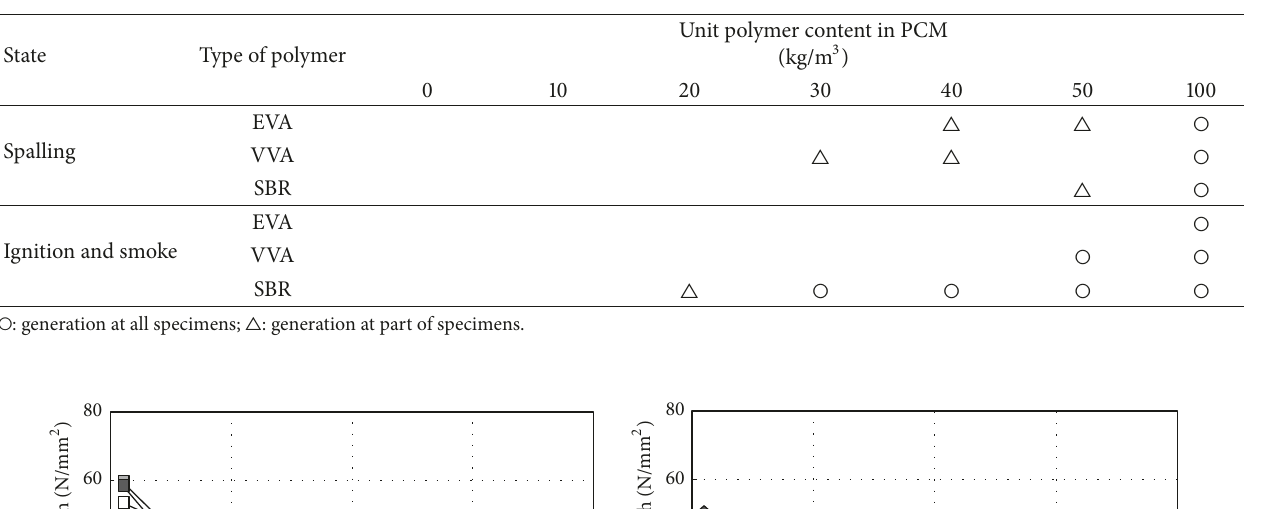
Table 4: Observation of specimens.